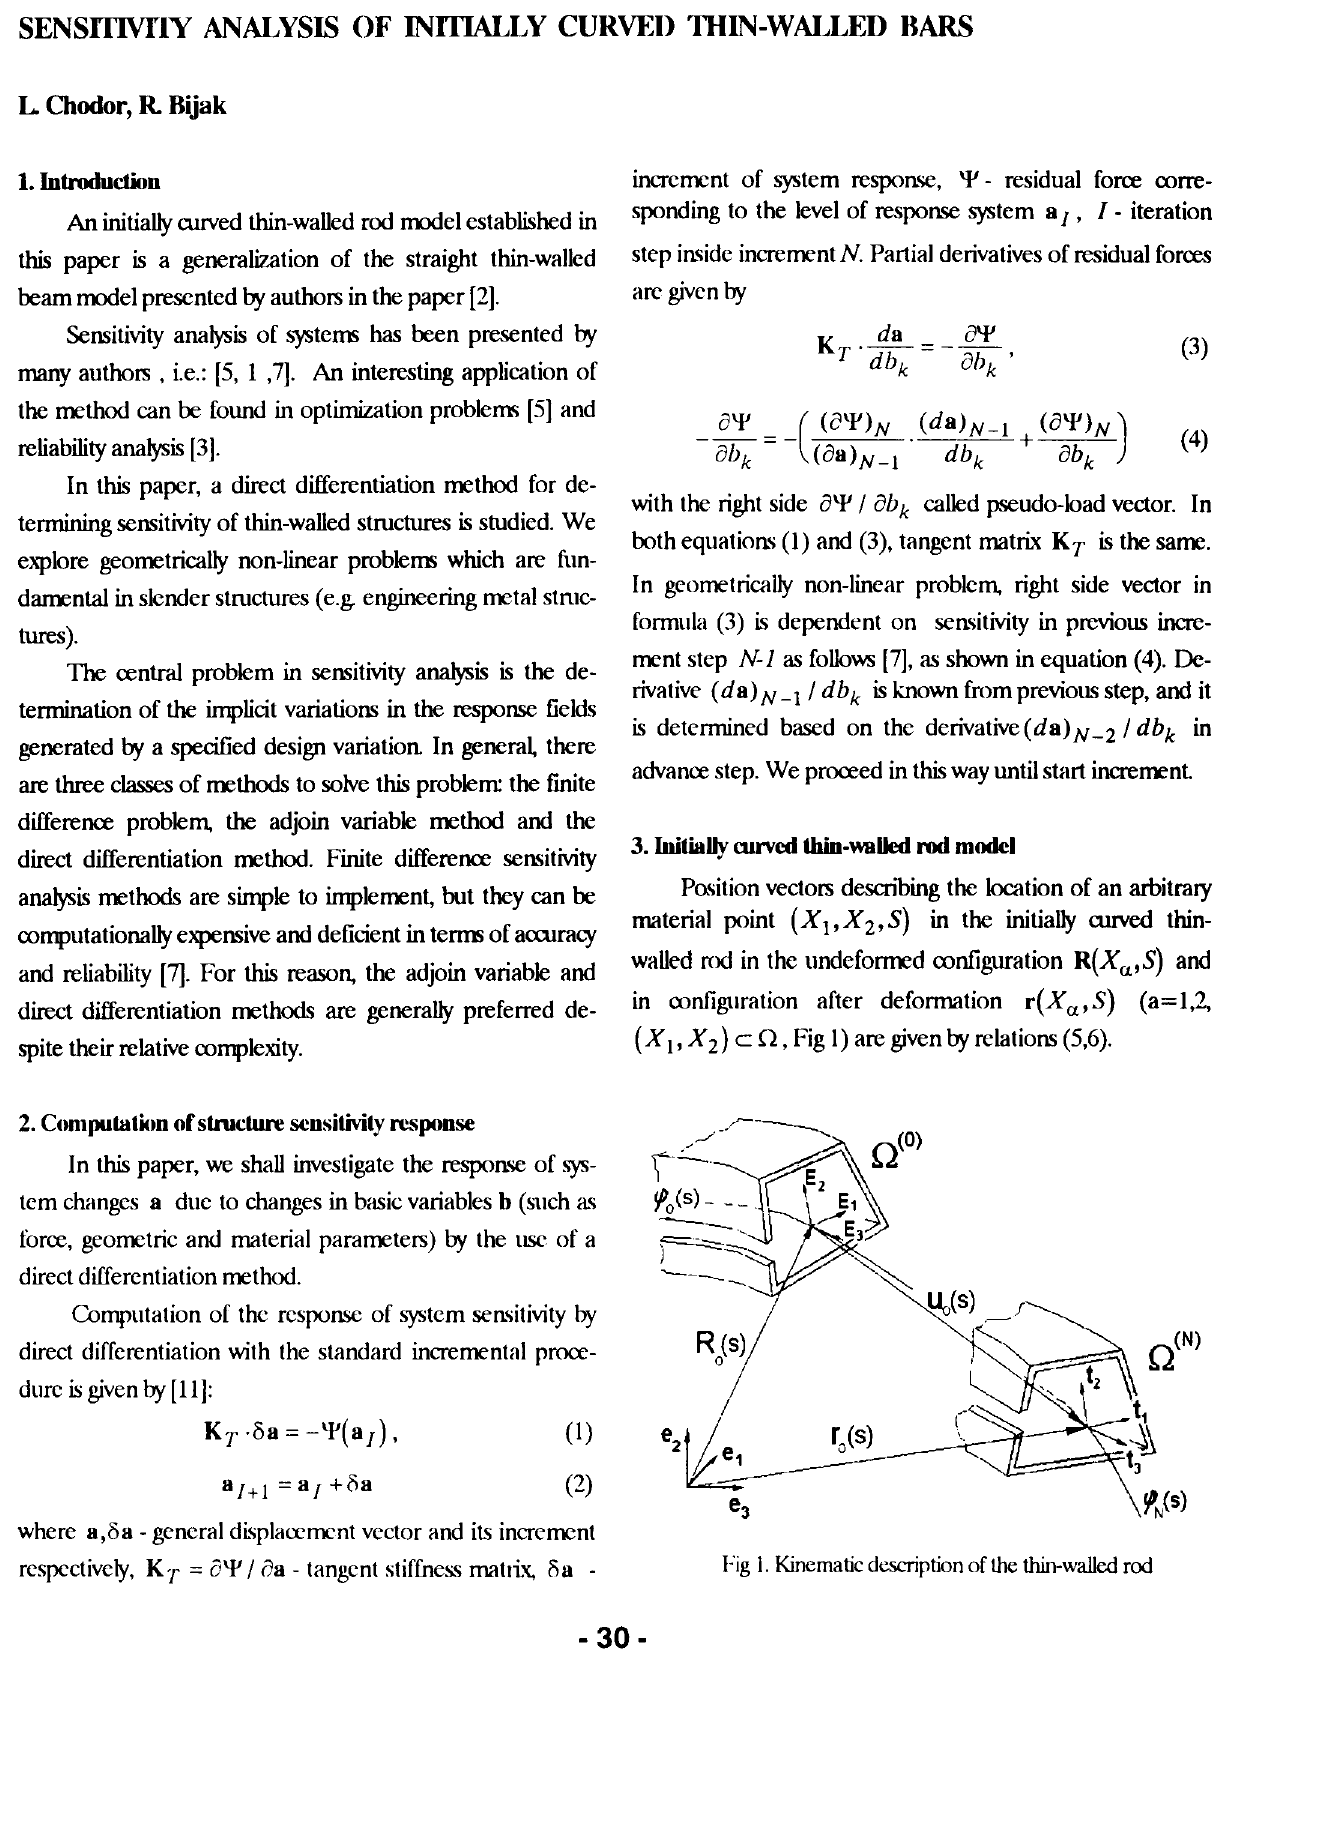
Fig I. Kinematic description of the thin-walled